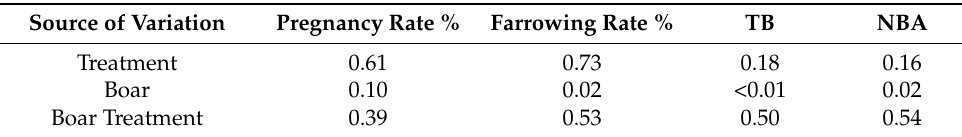
Table 3. Effect of boar and red LED light treatment on reproductive parameters. ANOVA source of variation.